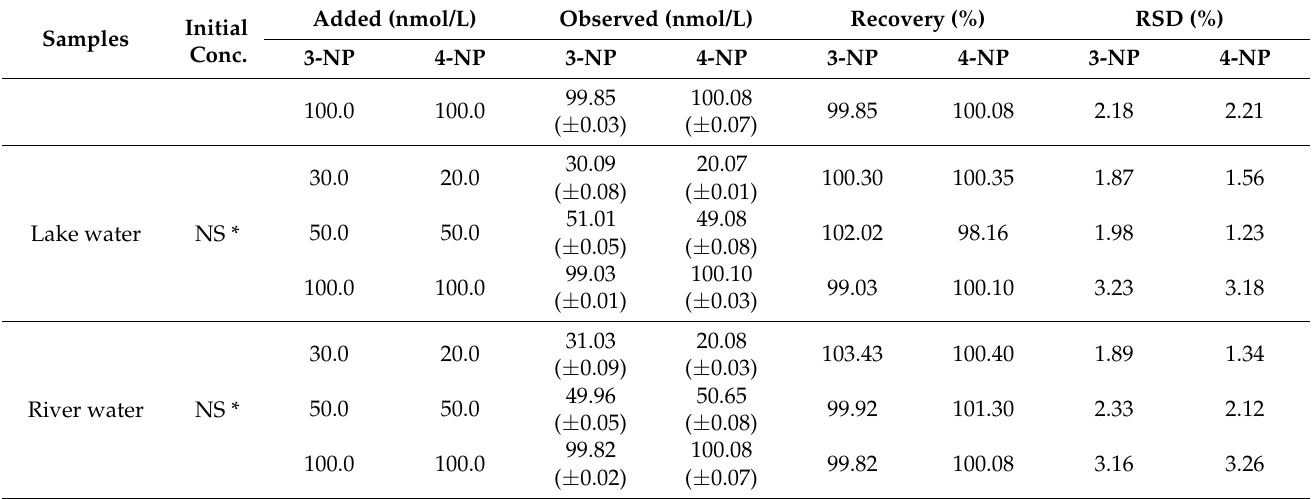
Figure S2: Electrochemical polymerization of thionine on APGE surface in 0.1 M PBS electrolyte at scan rate of 50 mV/s for 30 segments and Figure S3: Stability studies of APGE/PTH towards simultaneous sensing of 3-NP and